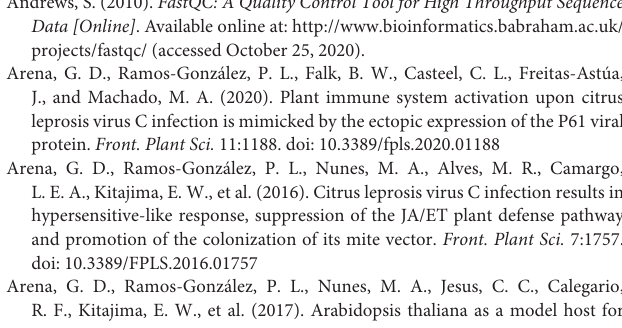
Supplementary Figure 1 | Bayesian maximum clade credibility tree inferred using a Markov Chain Monte Carlo (MCMC) of the CiLV-C of the lineages CRD (blue branches), SJP (pink branches), and ASU (yellow branches) based on p29 (A) and p32 (B) ORFs. CiLV-C2 sequences (black branches) were used as an outgroup and trees were generated with 6,000,000 generations. The color-coded based collection sites show whether the sample was obtained from commercial orchards in the citrus belt of São Paulo (SP) and Minas Gerais (MG) states (in green), from non-commercial citrus trees of SP and MG (in gold), from other Brazilian states (in mauve), or other countries, i.e., Argentina, Colombia, Mexico, Panama, and Paraguay (in brown). Supplementary Figure 2 | Bayesian maximum-clade-credibility (MCC) time-scaled phylogenetic tree ( A ) and analyses of the temporal signal by linear regression approach ( B ) using the complete sequence of RdRp – p29 – p61 – p32 – p24 ORFs from 23 CiLV-C isolates collected in the period 1932–2020 in South America. (A) Horizontal gray bars on nodes A, B, C, and D indicate the uncertainty for the date of each node (95% highest posterior density—HPD—intervals). Figures near the main nodes represent the posterior probability values. The color-coded based collection sites show whether the sample was obtained from commercial orchards in the citrus belt of São Paulo (SP) and Minas Gerais (MG) states (in green), from non-commercial citrus trees of SP and MG (in gold), from other Brazilian states (in mauve), or other countries, i.e., Argentina, Colombia, Mexico, Panama, and Paraguay (in brown). The phylogenetic tree was edited using IcyTree; (B) The temporal signal was calculated using TempEst v. 1.5.3 software. Root-to-tip divergence as a function of sampling time for Maximum likelihood non-clock tree generated by IQtree v. 1.5.5 software. Supplementary Figure 3 | Analyses of the temporal signal by linear regression approach from the concatenate of the p29 (795 nt) and partial p32 (288 nt) of 132 isolates of CiLV-C using TempEst v. 1.5.3 software. Root-to-tip divergence as a function of sampling time for Maximum likelihood non-clock tree generated by IQtree v. 1.5.5 software. Supplementary Table 1 | Complete list of plant samples and citrus leprosis virus C (CiLV-C) sequences analyzed in this study. Supplementary Table 2 | Nucleotide and haplotypic diversities of ORFs p29 and p32 of CiLV-C. Nucleotide sequences were amplified and cloned from samples of infected Citrus sinensis trees collected in commercial orchards of the citrus belt São Paulo—Minas Gerais, Brazil, in 2017. Supplementary Table 3 | Nucleotide and deduced amino acid identities (%) among CiLV-C isolates described in this study and the type members of the clades CRD (CiLV-C_BR_SP_Crd01, GenBank accession numbers NC008169 and NC008170) and SJP (CiLV-C_BR_SP_SJP01, GB acc. numbers KP336746 and KP336747).